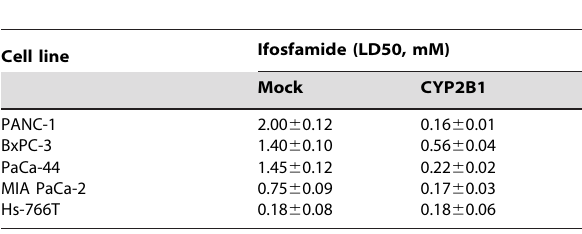
Table 4. Sensitivity of human pancreatic cancer cell lines towards